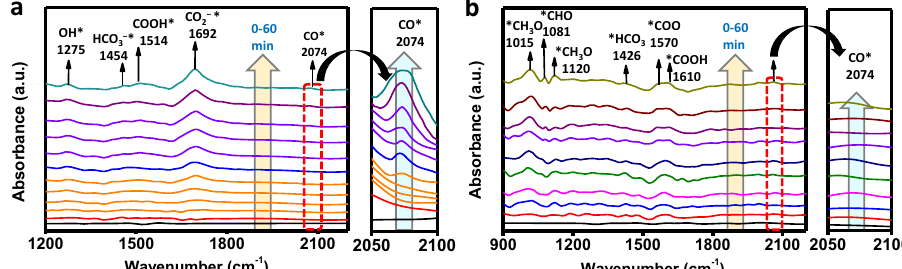
Fig. 8 Real-time photocatalytic CO 2 reduction monitoring through in situ DRIFT study. a For CO formation by Zn-TPY-TTF CPG. b For CH 4 formation by Pt@Zn-TPY-TTF